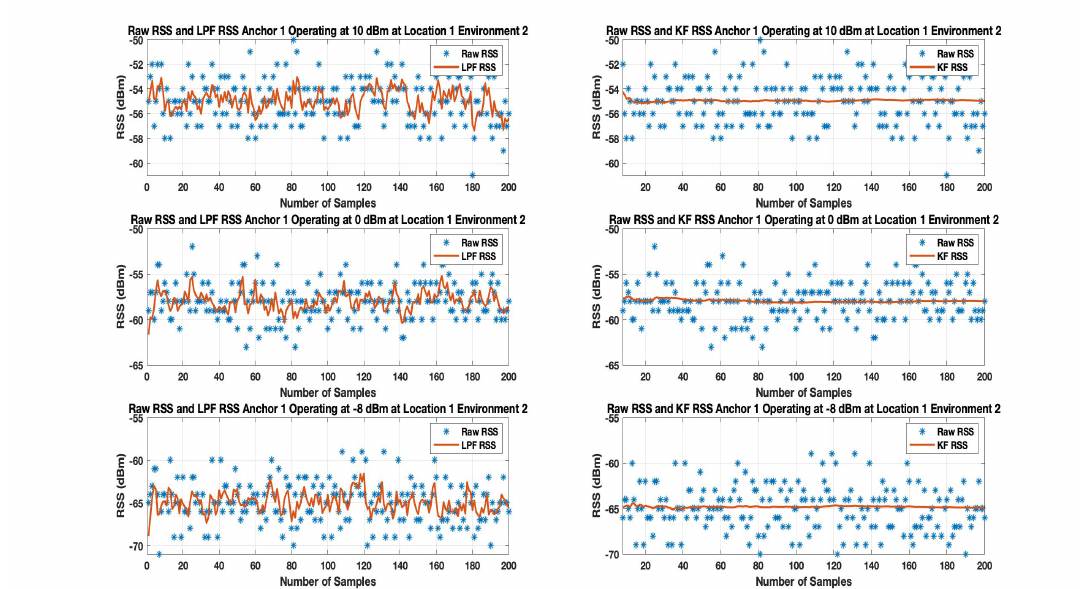
Figure 12. Result of LPF and KF on Anchor A 1 RSS operating at 10 dBm, 0 dBm and − 8 dBm at Location 1 in Environment